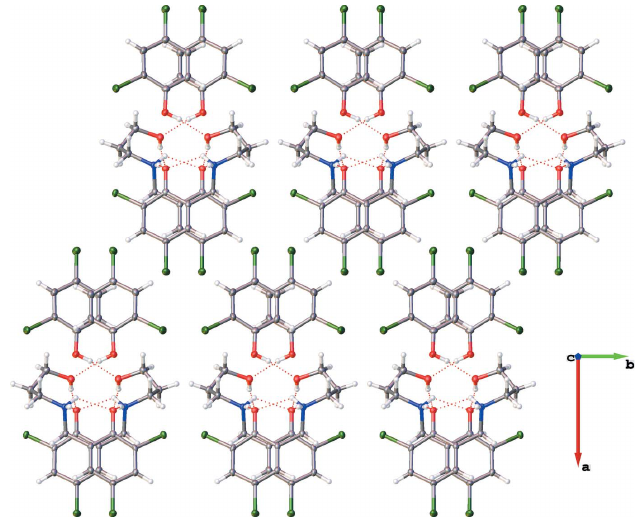
Figure 4 Packing diagram of the title compound viewed down the c axis, depicting an apparent regular mirror image resulting from the glide plane in the ac plane.